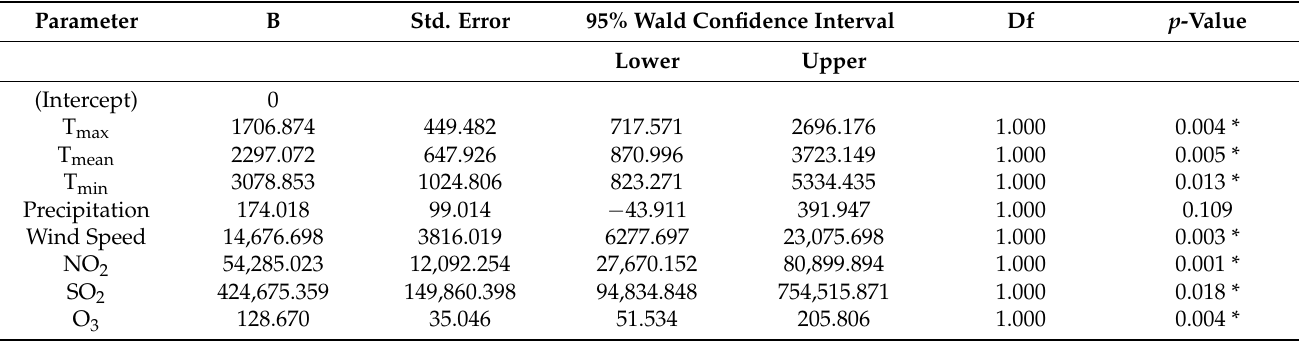
Table 7. Generalized Linear Model (GLM) parameters estimates for Pakistan in the period of Feb. 2019–Jan. 2020.